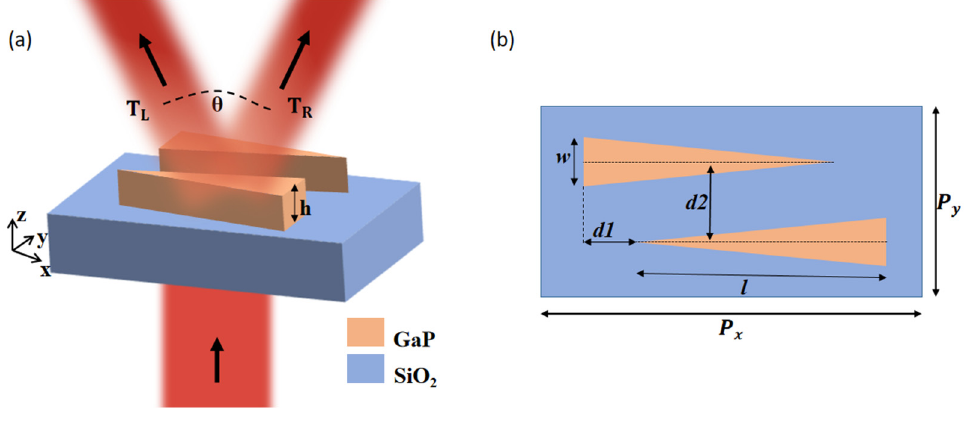
Figure 1. ( a ) Schematic of one unit cell of the proposed beam splitter and ( b ) top view of the beam splitter structure.